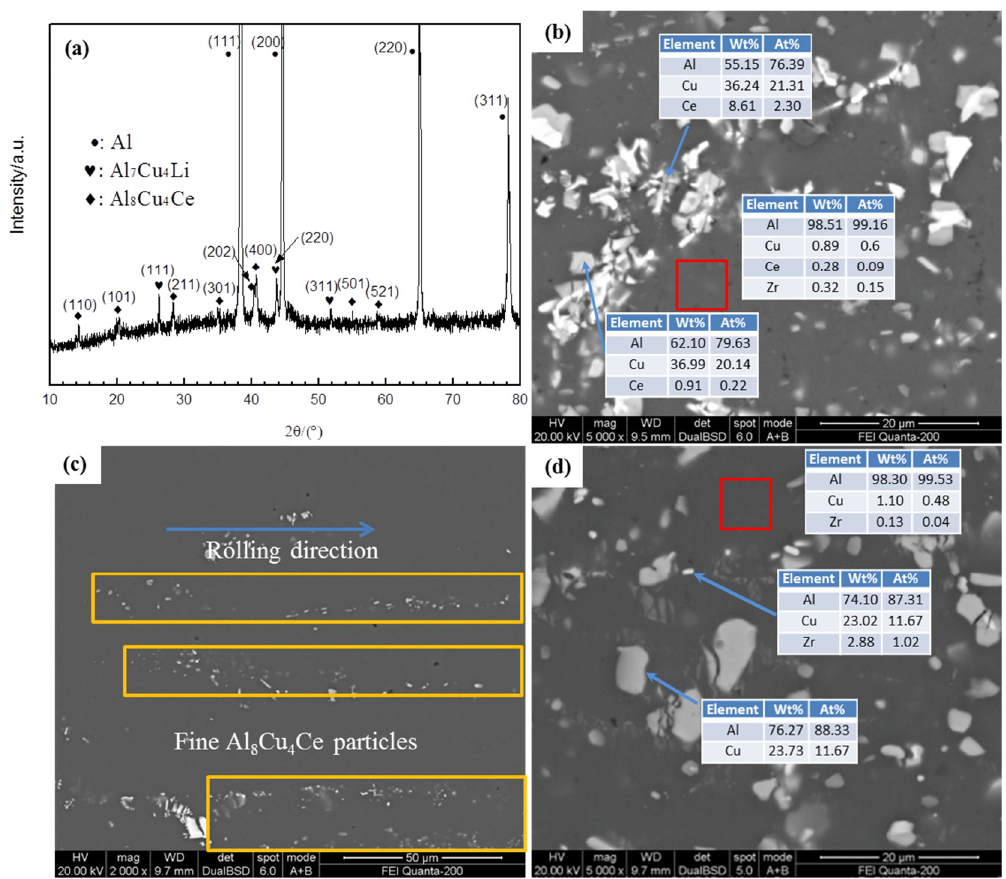
Figure 10. ( a ) XRD patterns of Ce-containing alloy; precipitate characterization and EDS analysis of Ce-containing alloy, ( b ) cold rolled and ( c ) after annealing at 520 °C for 1 h; ( d ) Precipitate characterization and EDS analysis for cold rolled Ce-free alloy.